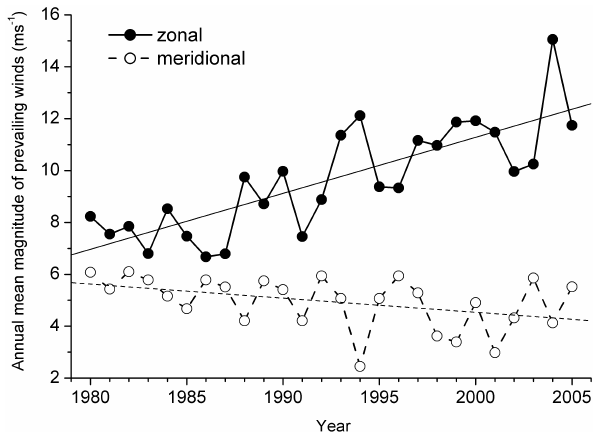
Fig. 9. Annual mean magnitudes of zonal and meridional prevailing winds over